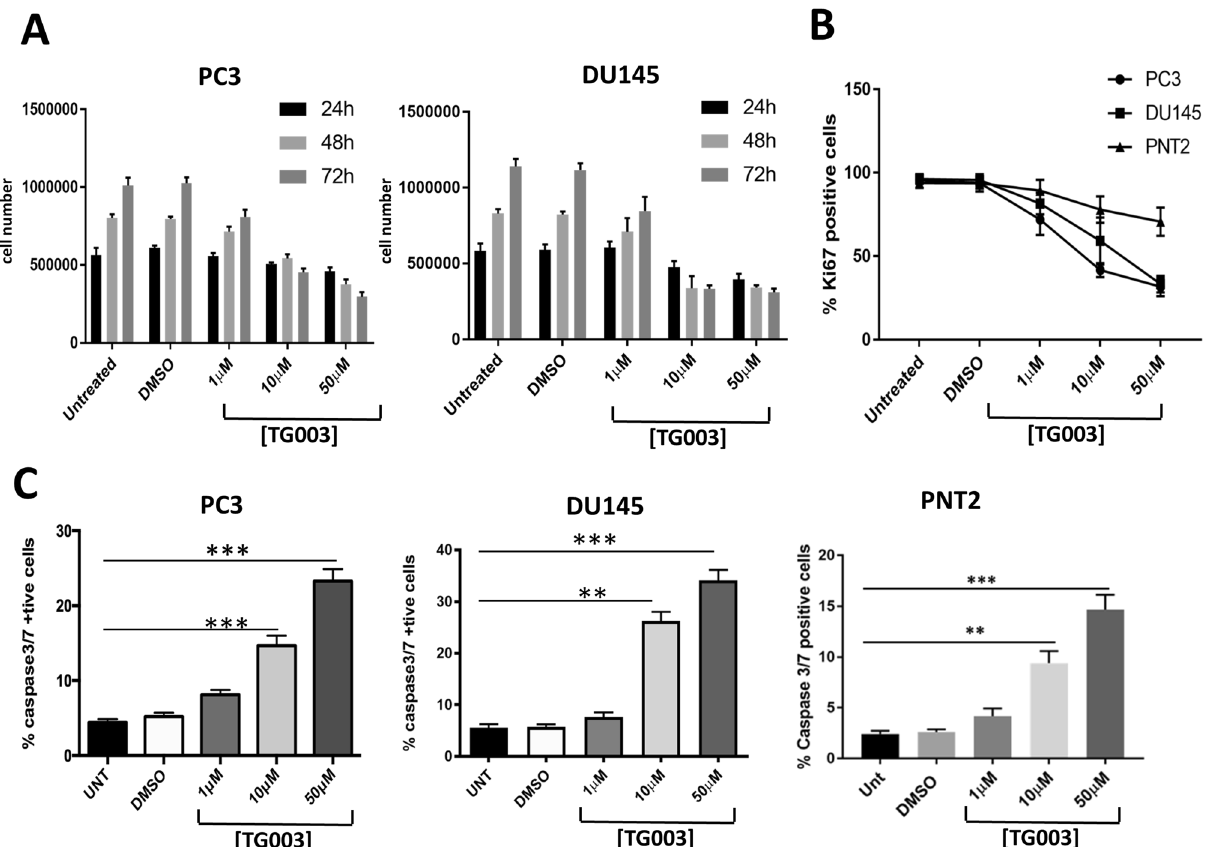
Figure 1. Effect of TG003 on cell proliferation and apoptosis. ( A ) PC3 and DU145 prostate cancer cell lines were treated with 1, 10 and 50 µM TG003. Viable cells were counted at 24, 48, and 72 h following treatment (trypan blue assay). Untreated and DMSO controls are included. ( B ) The proportion of Ki67-positive proliferating cells was measured in PC3 and DU145 prostate cancer and in PNT2 normal prostate epithelium cells. ( C ) The percentage of apoptotic cells was measured via caspase 3/7 staining following 48 h of exposure to TG003. N = 3 repeats in all experiments. ** p < 0.01; *** p <